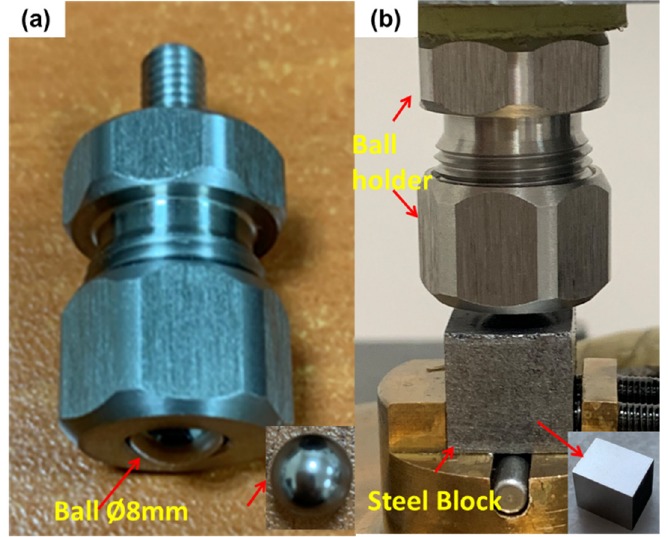
Figure 3 . Ball and block specimen configuration: ( a ) ball placed in the holder and ( b ) ball holder and steel block integrated configuration.